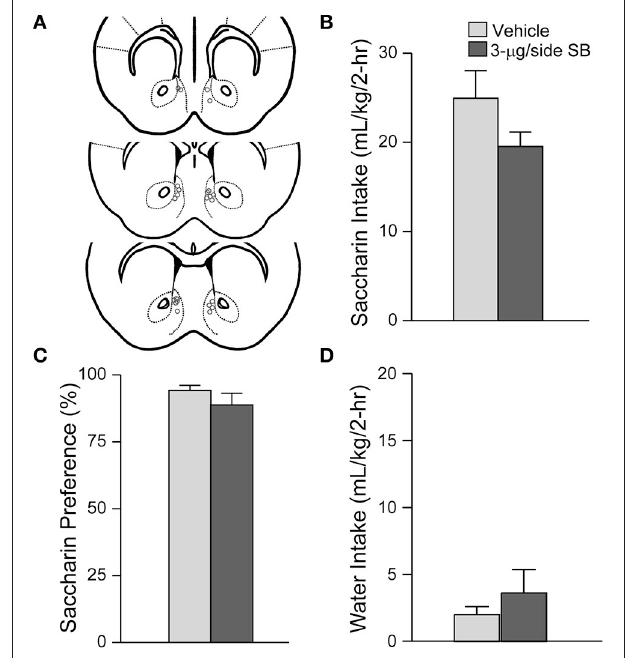
FIGURE 1 | OX1R blockade within the medial NAc Shell significantly reduced alcohol drinking in mice. (A) Locations of cannulae shown by gray circles; sections at approximately AP + 1.34, + 1.18 and + 0.98mm relative to Bregma. (B) Infusion of 3- µ g SB within the mNAsh decreased alcohol intake. (C,D) No changes in (C) alcohol preference or (D) concurrent water intake. Preference was calculated as (ml alcohol)/(ml alcohol + ml water). * p < 0.05.